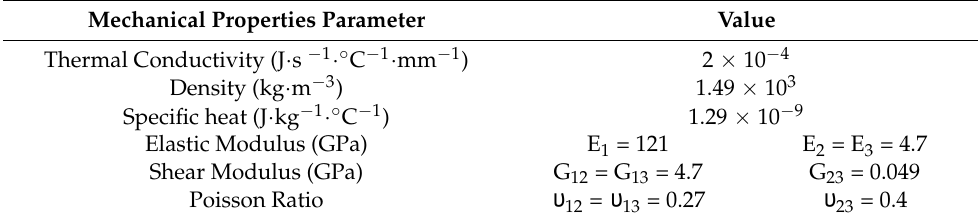
Table 1. Mechanical properties of 6511 type carbon fiber/epoxy prepreg tape 1 .